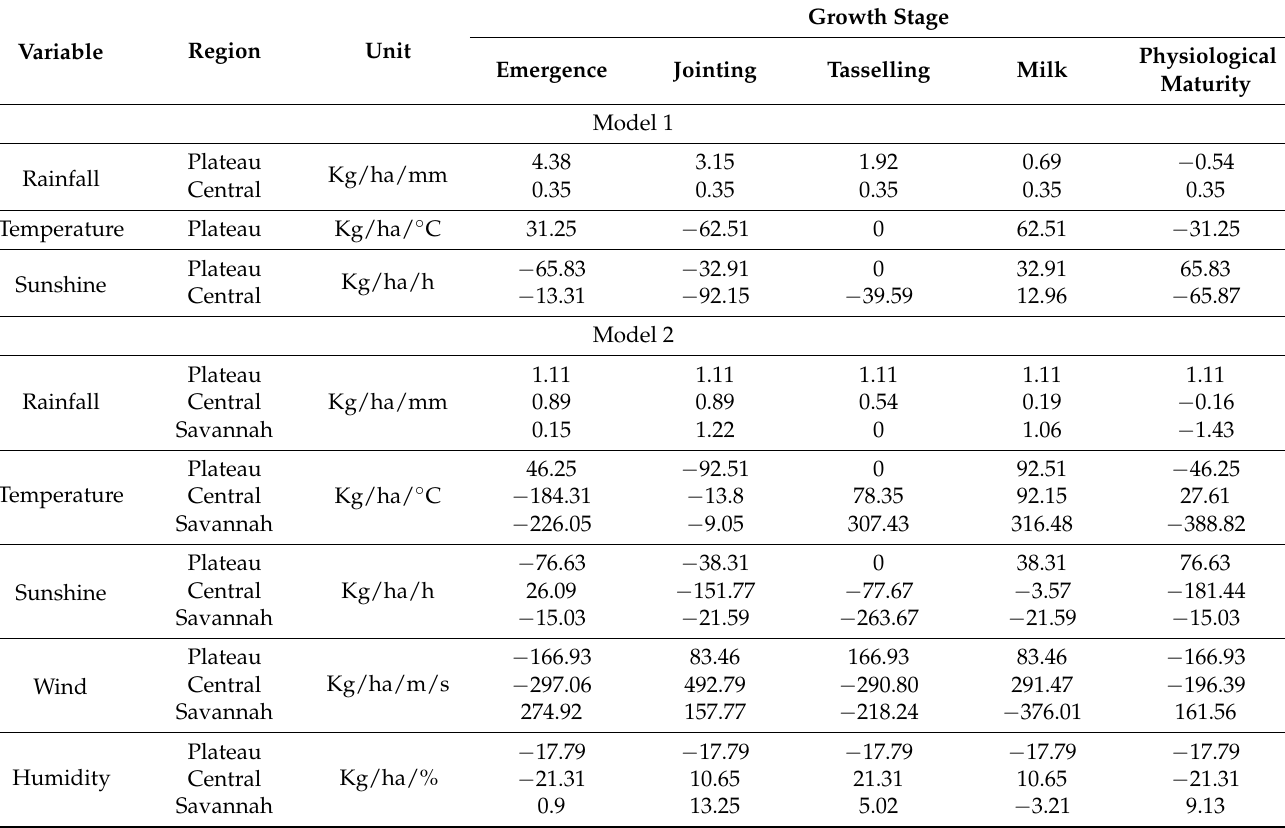
Table 7. The yield coefficients for weather-related factors on maize yield by growth stage from the Chebyshev polynomial function.